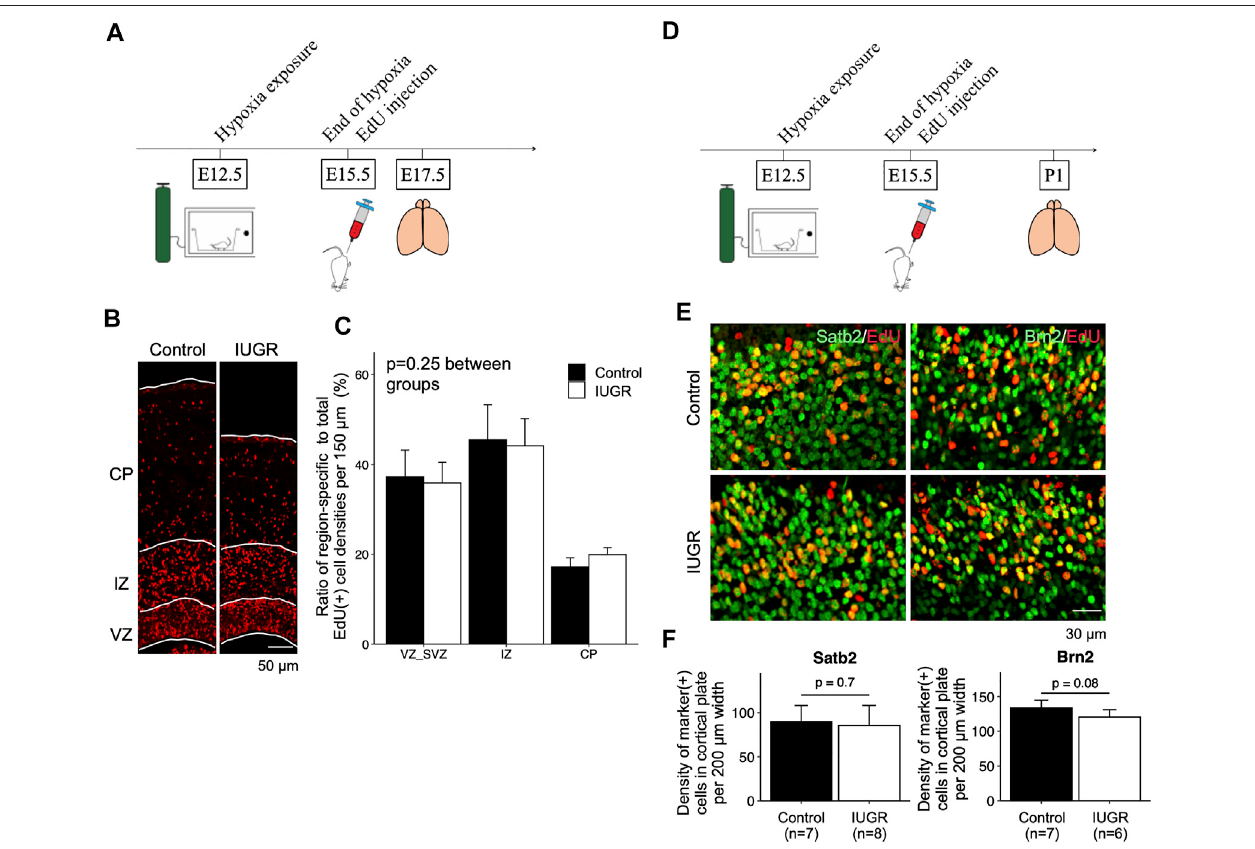
FIGURE 4 | Gestational time-corresponding layer-speci fi c neuron production was resumed following relief from maternal hypoxia exposure. (A) Schematic representation of experimental design. Note that brains were harvested on embryonic day (E)17.5. (B) Immuno fl uorescence staining of EdU in the control ( n = 6) and IUGR( n =6)groups. (C) Quanti fi cationofthecellsinpanelBshowingtheproportionoftheregion-speci fi cEdU(+)celldensitytototalEdU(+)celldensityperview.Atwo- wayANOVAtestshowednosigni fi cantdifferencebetweenexperimentalgroups( p =0.25)butsigni fi cantdifferenceamongbrainregions( p < 0.001). (D) Schematic representation of experimental design. Note that brains were harvested on postnatal day (P) 1. (E) Immuno fl uorescence staining showing cells co-expressing EdU and Satb2/Brn2. (F) Quanti fi cation of the cells in panel E showing the densities of cells co-expressing EdU and indicated lineage marker.